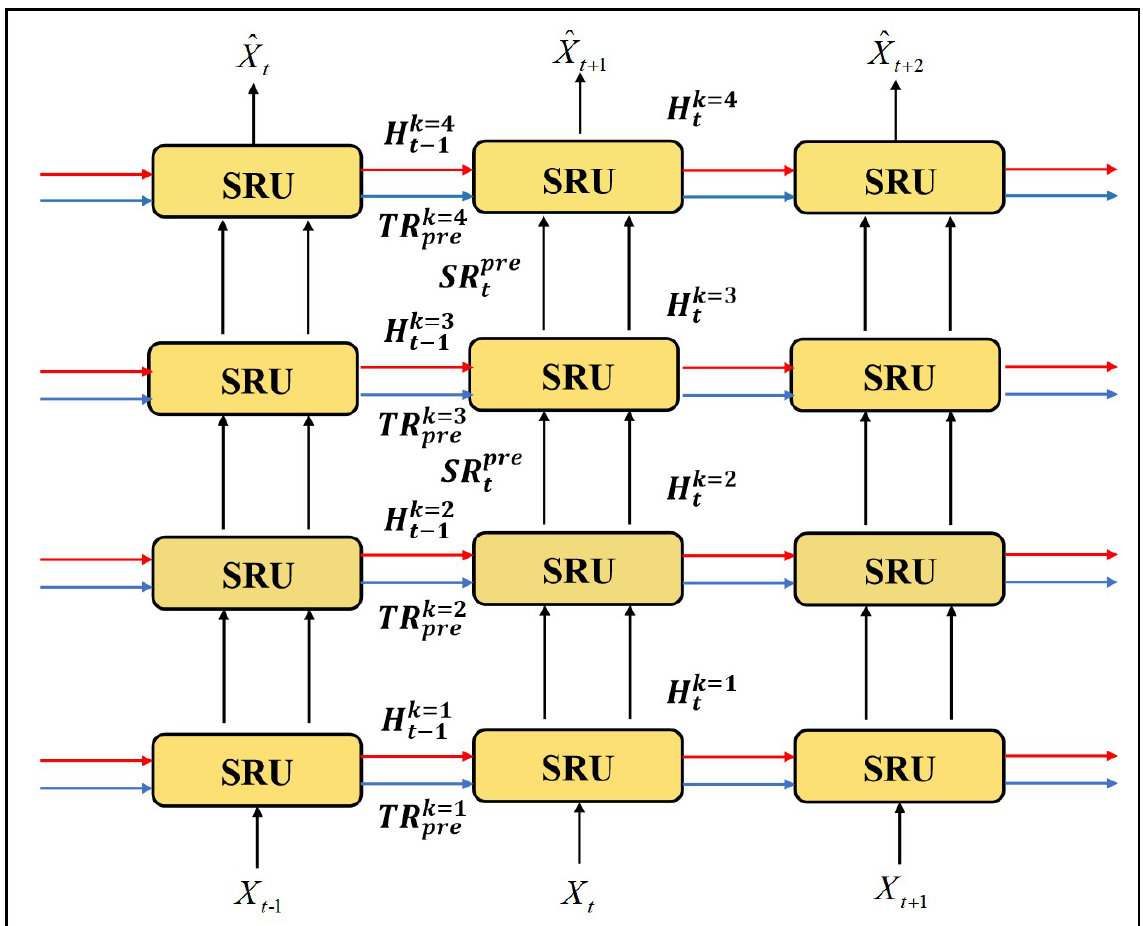
Figure 4. Stacked SRU